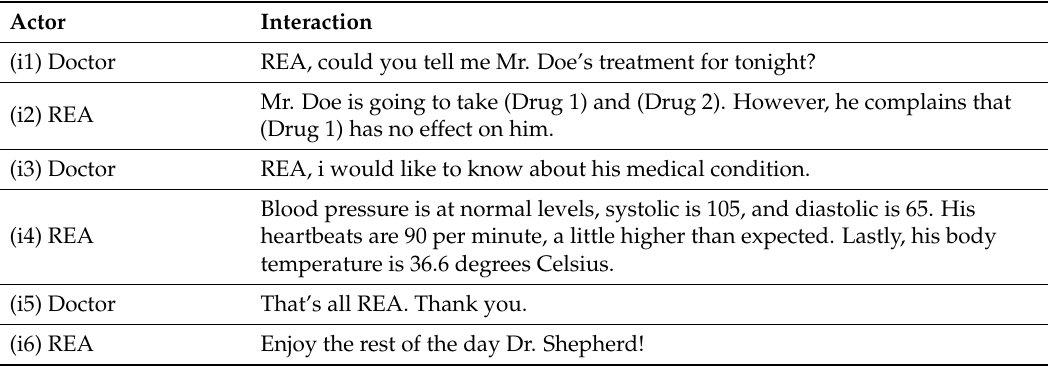
Table 1. Doctor-agent use-case